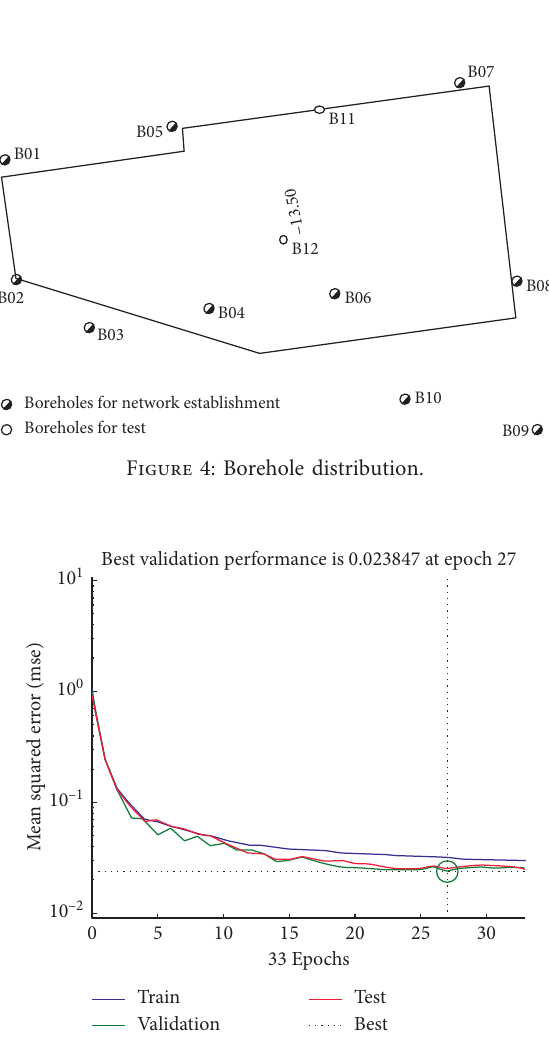
Figure 5: Error performance